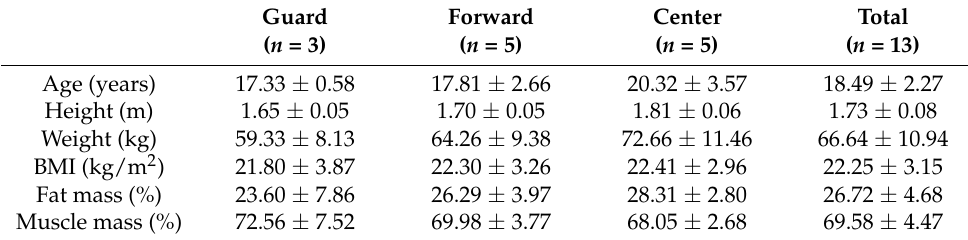
Table 1. Anthropometric characteristics of women’s basketball players in the present study.